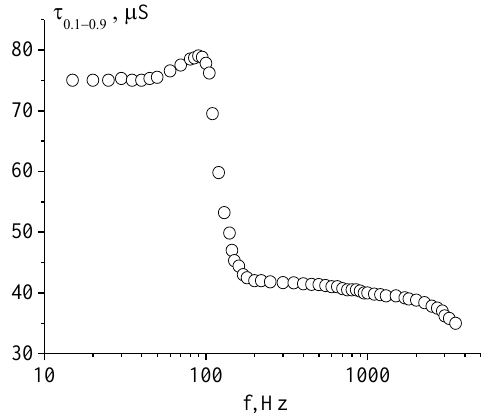
Figure 4. Frequency dependence of the optical response time for the HF-32B composition at V = ± 1.5 V. The bipolar voltage is of the rectangular shape (meander). The thickness of the electro-optical cell is 1.7 μm.